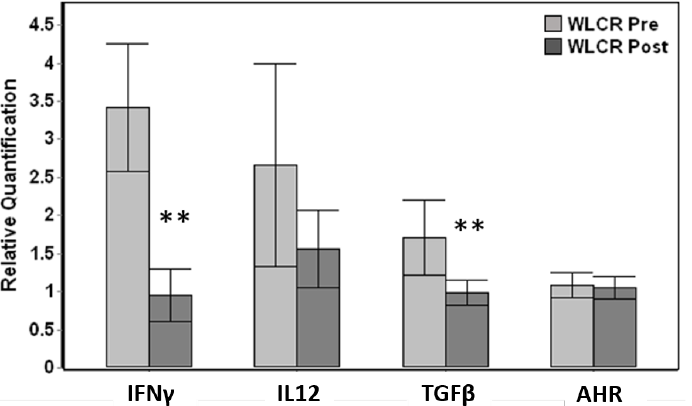
Figure 4. Comparison of relative gene expression changes of paired pre-health assessment (WLCR Pre) and post-health assessment (WLCR Post) blood samples ( n = 15) obtained from live capture- release whales from Bristol Bay. The genes that are significantly different from pre are indicated with asterisks. Error bars represent the standard error of means. The relative quantification values were obtained by normalizing the ∆ Cq values to the average expression for each gene across all the samples obtained from wild belugas. Genes that showed significant variation between pre and post samples are indicated with asterisks (Wilcoxon paired test, ** p